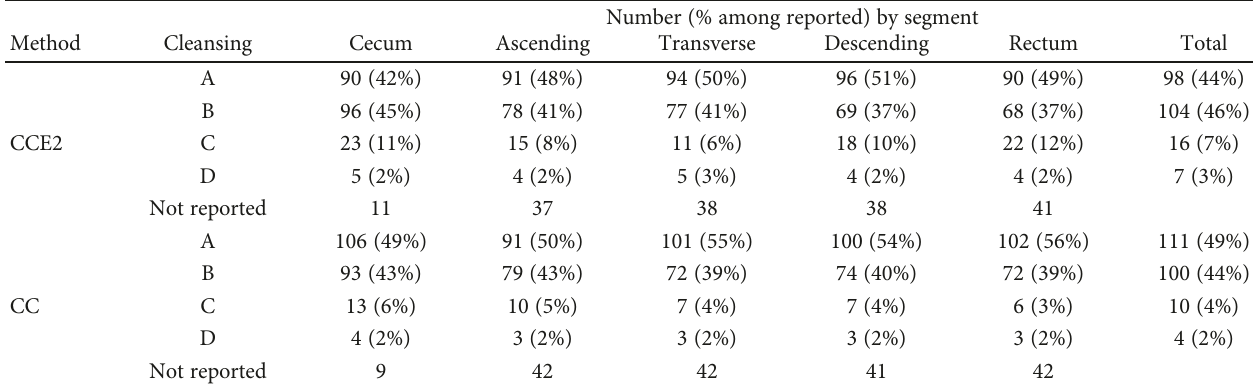
Table 4: Level of bowel preparation (CCE2 and CC, N = 225 ). Number (% among reported) by